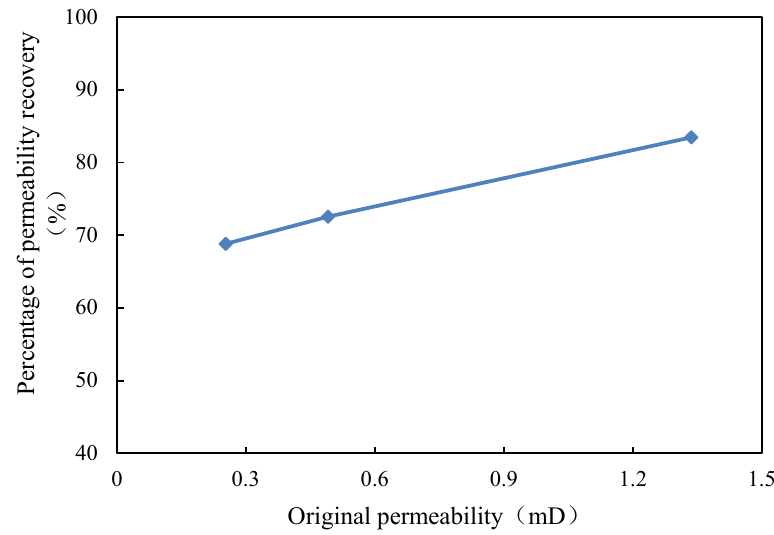
Figure 6. Relationship between permeability recovery rate and original permeability.